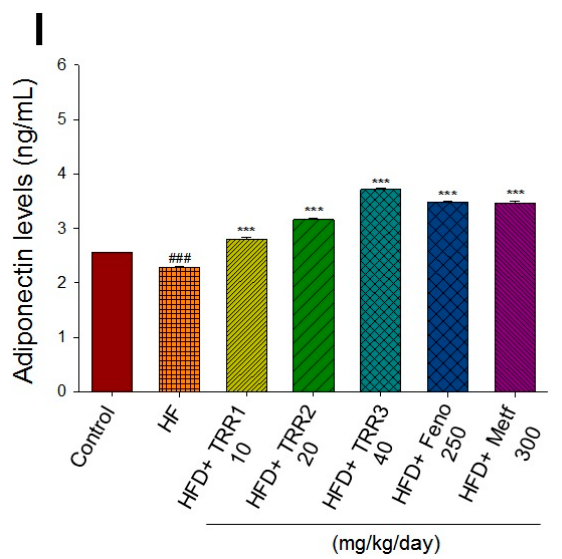
Figure 3. Effects of TRR including two parts. ( A ) Oral glucose tolerance (OGTT) was performed on 12 h fasted ICR mice ( n = 5) that were allowed access to 40 and 80 mg/kg TRR or an equivalent amount of vehicle (water), which were given orally 30 min before an oral glucose load (1 g/kg body weight). The control group was given glucose, whereas the normal group was not. Blood samples were collected from the retro-orbital sinus of fasted mice at the time of the glucose administration (0) and every 30 until 120 min after glucose administration and the blood glucose level was monitored. Each point is the mean ± standard error (SE) of five separate mice. ### p < 0.001 compared with the control (CON) group; *** p < 0.001 were significantly different compared with the control group in the same time by ANOVA. ( B – I ) Effects of eburicoic acid (TRR) on ( B ) body weights, ( C ) relative tissue weight (%), ( D ) blood glucose levels, ( E ) blood triglycerides levels, ( F ) blood total cholesterol levels, ( G ) insulin levels, ( H ) leptin levels, and ( I ) adiponectin levels at week 14. Mice were fed with 45% high-fat diet (HFD) or low-fat diet (CON) for 14 weeks. After 14 weeks of induction, the HF mice were treated with vehicle, or eburicoic acid (TRR), or fenofibrate (Feno) or metformin (Metf) accompanied with HF diet for 4 weeks. All values are means ± SE ( n = 9). ## p < 0.01, ### p < 0.001 compared with the control (CON) group; * p < 0.05, ** p < 0.01, and *** p < 0.001 compared with the high-fat-diet (HFD) plus vehicle (distilled water) (HF) group using ANOVA and with Dunnett’s tests. EWAT: Epididymal white adipose tissue; Feno: Fenofibrate (250 mg/kg body weight); Metf: Metformin (300 mg/kg body weight); MWAT: Mesenteric white adipose tissue; RWAT: Retroperioneal white adipose tissue; TRR1, TRR2, or TRR3: 10, 20, or 40 mg/kg body weight eburicoic acid, respectively; Visceral fat: EWAT +